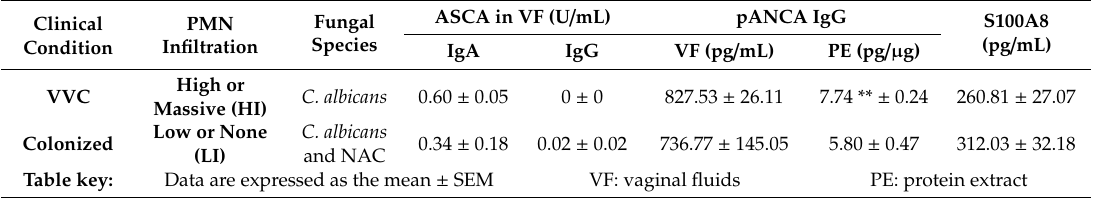
Table 1. Summary of the data (mean ± SEM) on anti- Saccharomyces cerevisiae antibodies (ASCA), anti-neutrophil cytoplasmic antibodies (pANCA) and S100A8 determination in vaginal fluids and protein extracts.